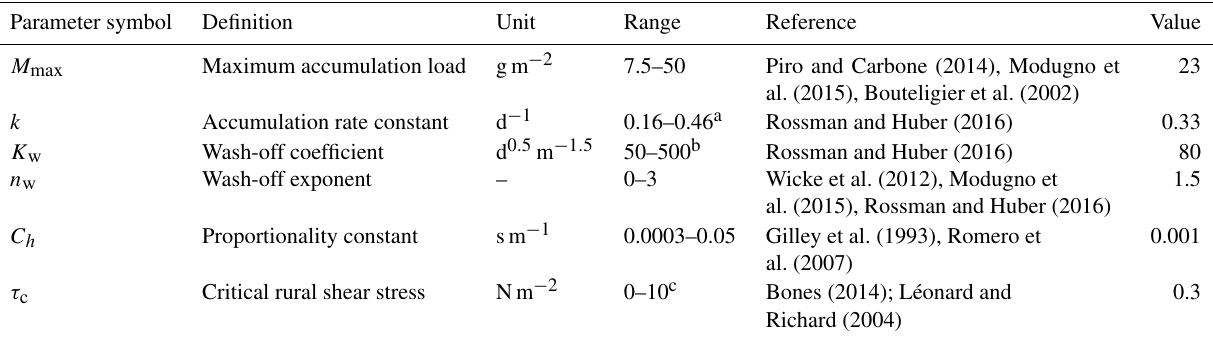
Table 2. Parameters of the sediment-generating model.